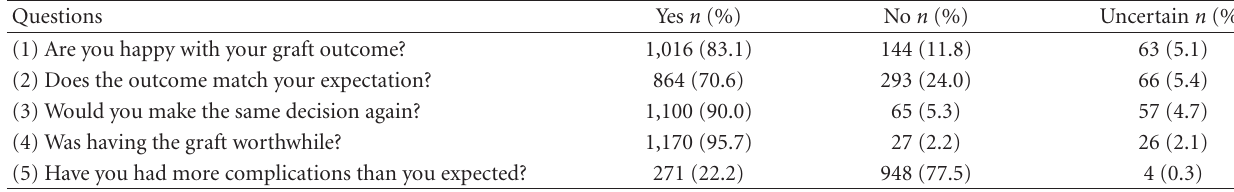
Table 5: Patients’ expectation and satisfaction.